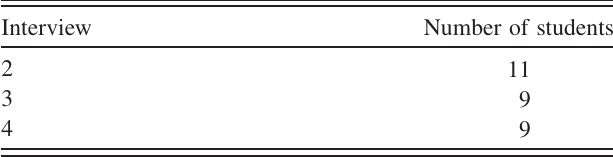
TABLE I. Number of students following the G-A sequence in each